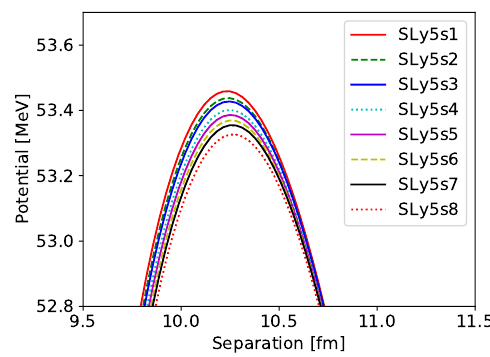
Figure 2. The Coulomb barrier, V FHF in (5), for 40 Ca + 48 Ca reactions using the Frozen Hartree-Fock (FHF) prescription for the eight SLyS n interactions. The highest barrier is for SLy5s1, and the lowest for SLy5s8, with a monotonic change in barrier height as the forces are traversed in index